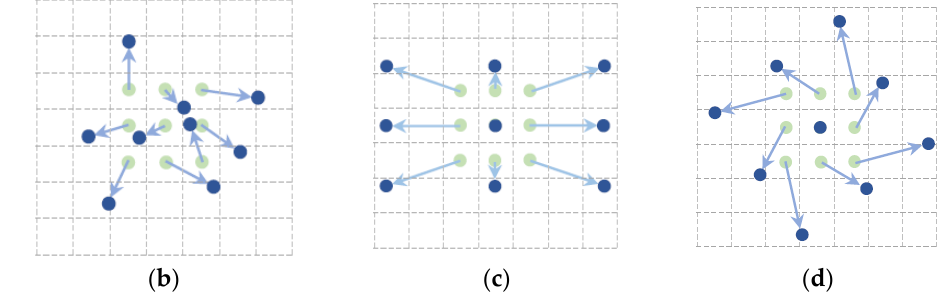
Figure 3. Comparison of deformable convolution sampling points of conventional 3 × 3 convolution kernel. ( a ) Conventional convolutional sampling position. ( b ) Random sampling of deformable convolutions. ( c ) Sampling position after deformable convolutional amplification. ( d ) Sampling position after deformable convolutional rotation.